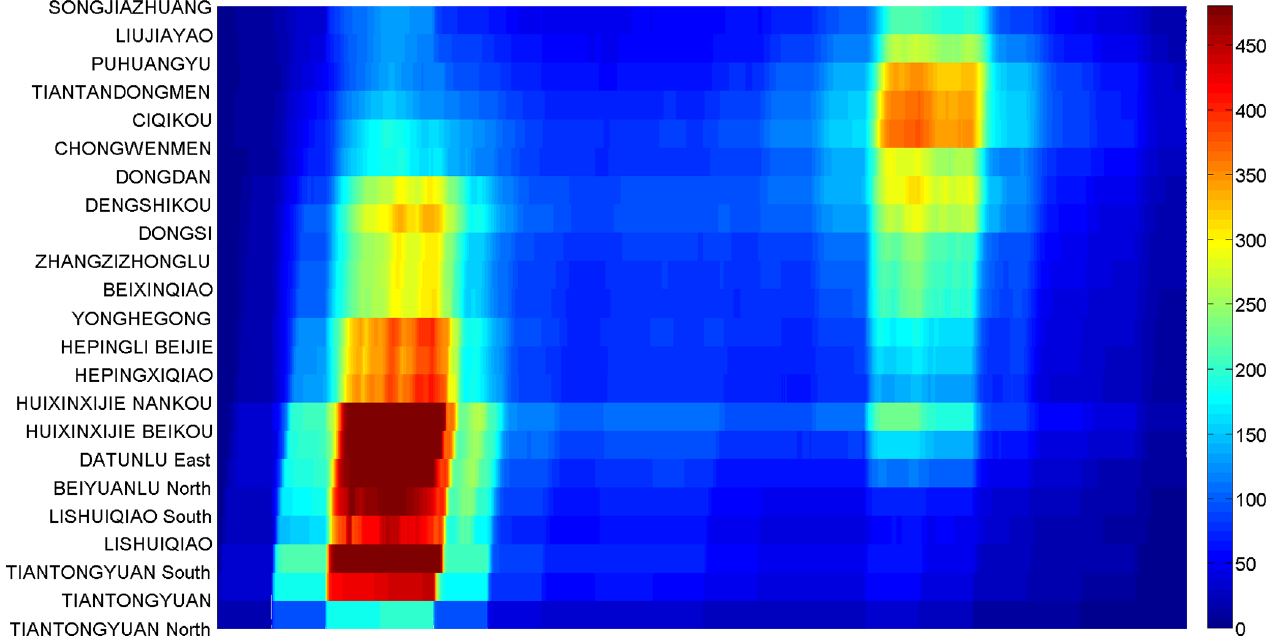
Fig 18. The space-time section flow distribution from Tiantongyuan North to Songjiazhuang.